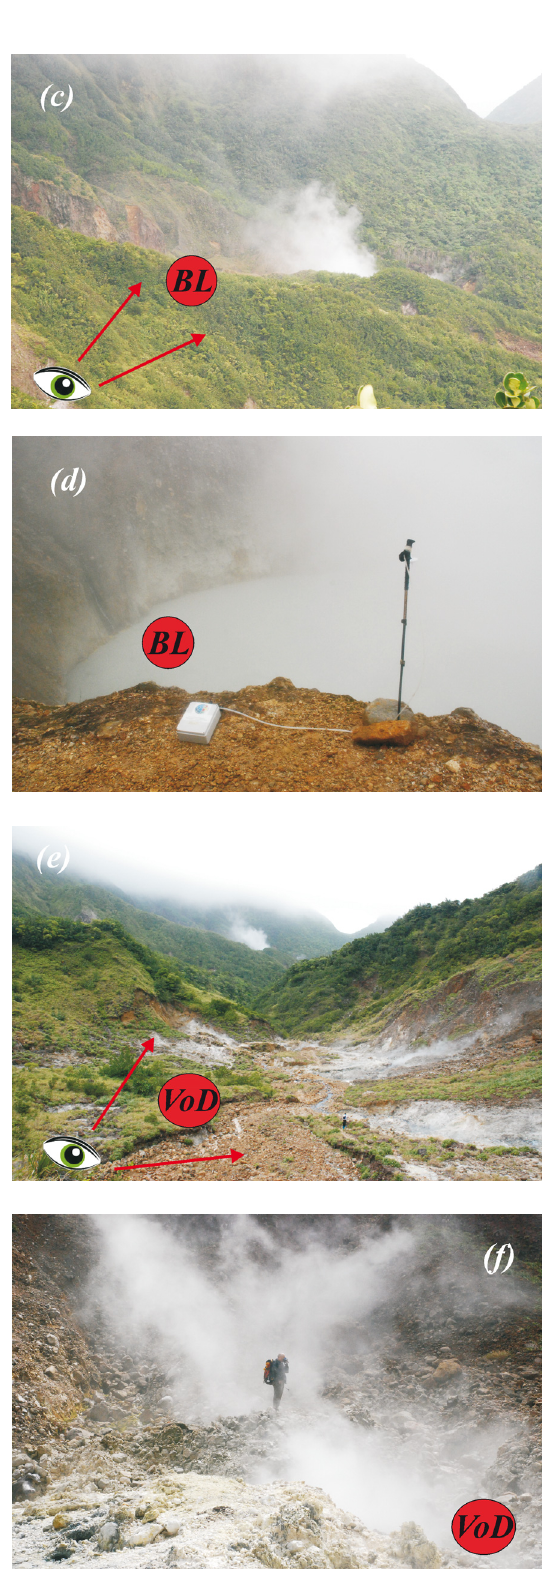
Figure 3. Image gallery from the Boiling Lake-Valley of Desolation area; (a) Google-Earth map of the study area (see Figure 2 for loca- tion); BL, VoD, and BG stand for measurement sites at Boiling Lake, Valley of Desolation, and at a background site (this site was remote enough from any visible manifestation); the track of the MultiGAS walking traverse made through and around the VoD fumarolic field is also shown (in red); (b, e) VoD and BL seen from south-west; (c) The Boiling Lake’s plume seen from the west; (d) fixed-position measurements at BL; (f) the walking traverse at